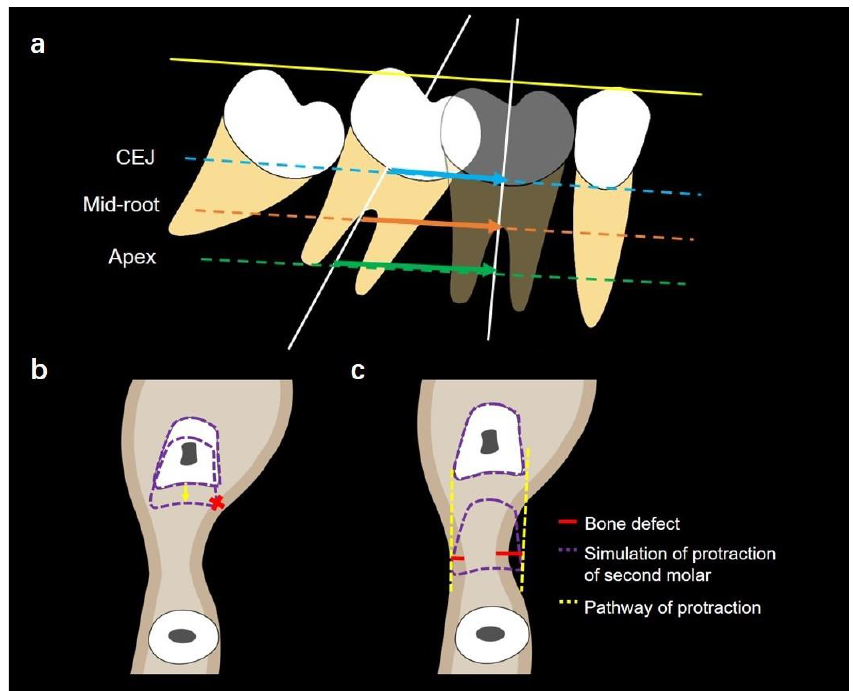
Figure 4. ( a ) Illustration showing the required mesialization distances of second molars. The second molar was mesialized to the position of the missing first molar through simulation. The line drawn from the most mesial mid-point of the original second molar and the mesialized second molar at CEJ (shown in blue arrow), mid-root (shown in orange arrow), and apex levels (shown in green arrow) was measured. ( b ) Illustration showing the available mesialization distances of second molars. The shortest distances (yellow line) from the most mesial mid-point of the original second molar to the mesialized second molar at CEJ, mid-root, and apex levels were measured when the second molar contacted the cortical bone through mesialization. ( c ) Illustration showing buccal and lingual bone defects of second molar protraction through 3D simulation. The line (shown in red line) perpendicular to the pathway of the second molar protraction (yellow dotted line) was drawn from the most concave inner layer of the bone cortex to the pathway of the second molar protraction on the buccal and lingual sides. Buccal and lingual bone defects (red lines) were measured.